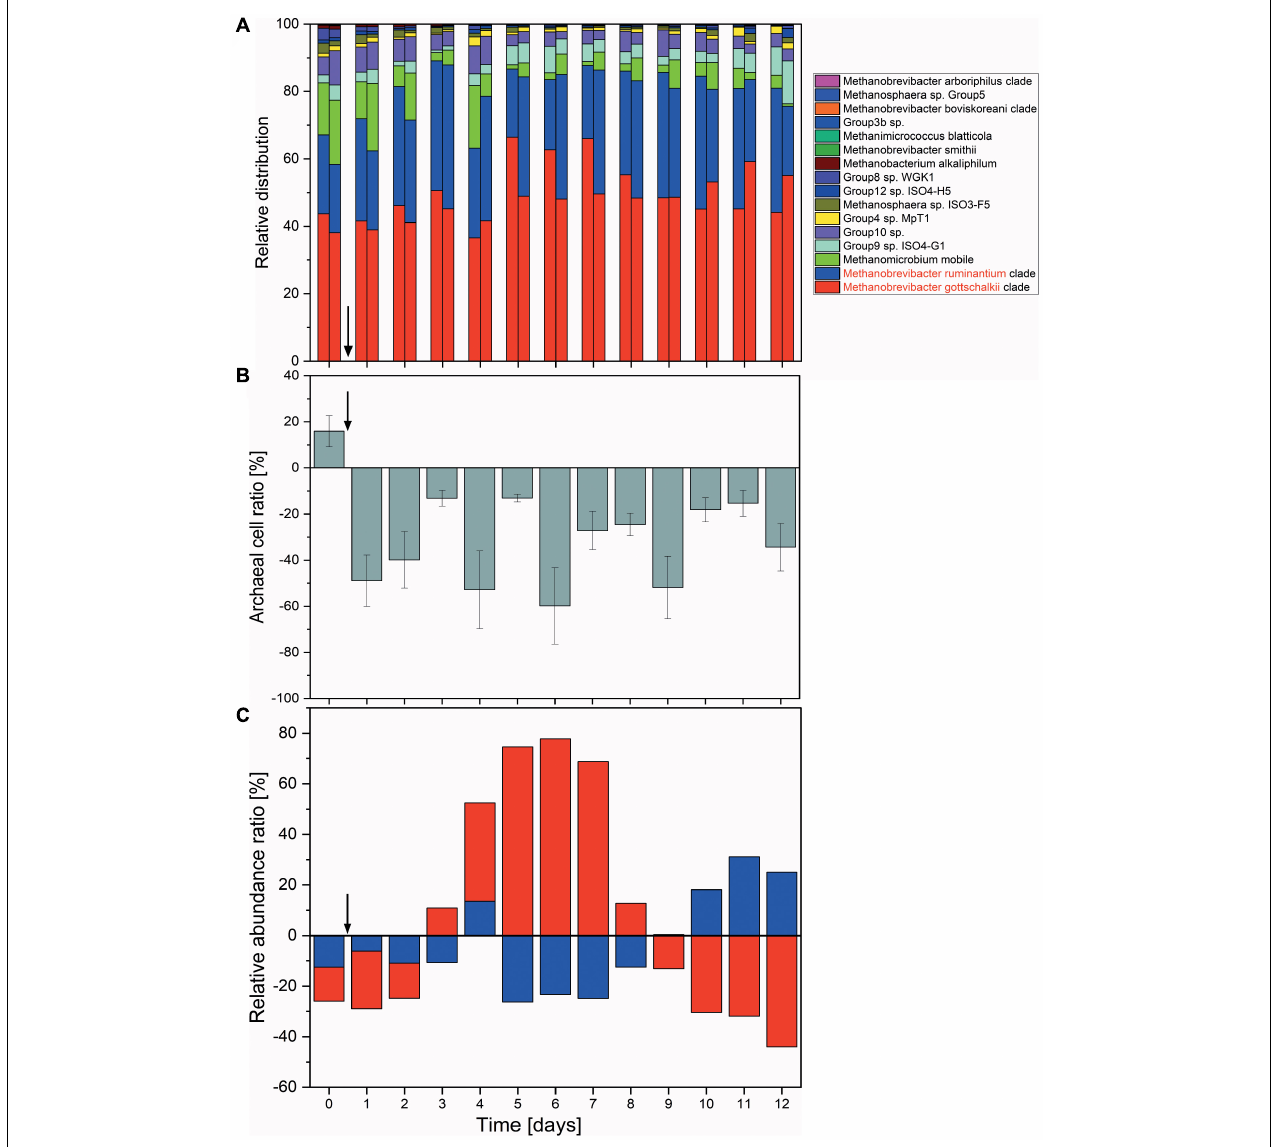
FIGURE 4 | Changes in the archaeal communities in a continuous flow fermentation system. (A) Relative abundances shown as the sum of proportions of the archaeal community quantified by 16S rRNA gene DNA sequencing. For each day, respective left columns represent non-functionalized nanoparticles (control) and right columns dual-fusion nanoparticles. (B) Ratio of absolute archaeal numbers (copies/ µ l) compared between non-functionalized and dual-fusion PeiR nanoparticle treatments. Values represent the average of three measurements per day over two vessels. Error bars indicate standard errors. (C) Changes in the relative abundances of M. ruminantium (red) and M. gottschalkii (blue) as compared between non-functionalized and dual-fusion PeiR nanoparticles. Values are averaged over 24 h and two fermentation vessels. Vertical arrows indicate the start of nanoparticle